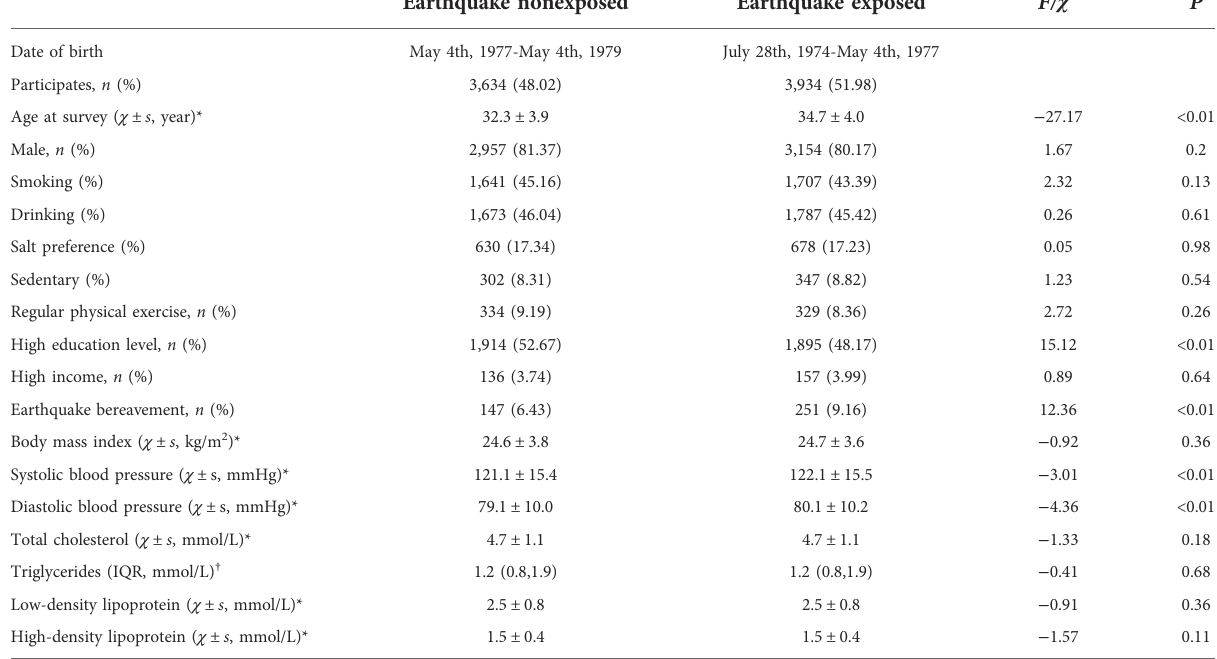
TABLE 1 Baseline characteristics by different earthquake exposure groups.